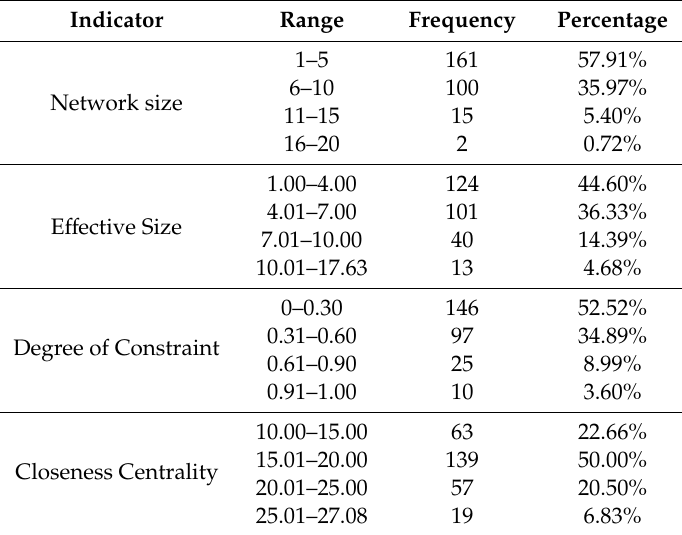
Figure 2. Social network of herdsmen in Qilian County. Each node represents a herder and each linkage between two nodes represents a relationship between two herders.